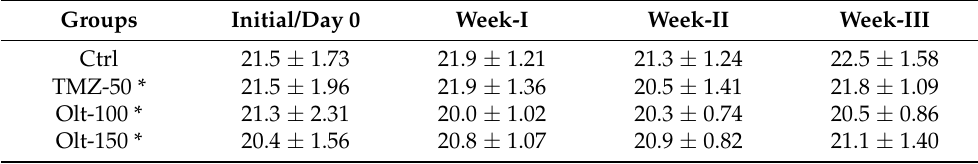
Table 1. Body Weight of tumor-bearing mice after oral administration of Olt for 21 days.